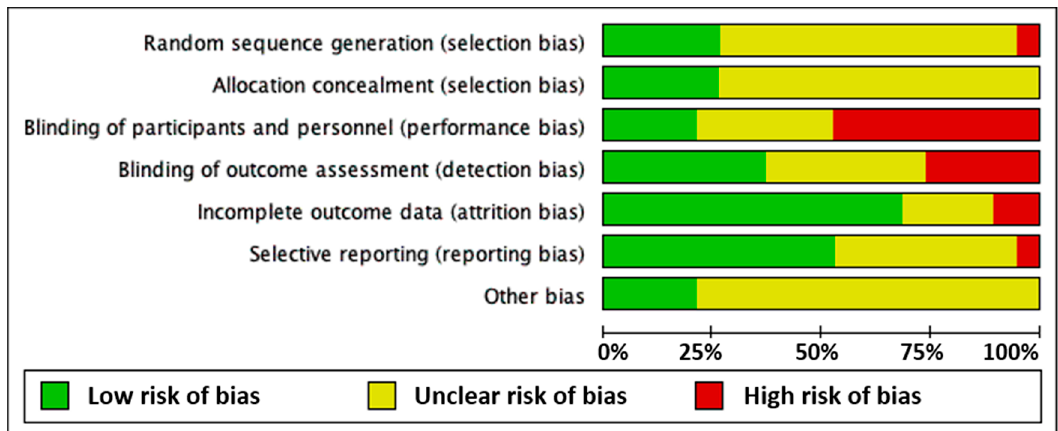
Figure 3. Risk of bias graph.